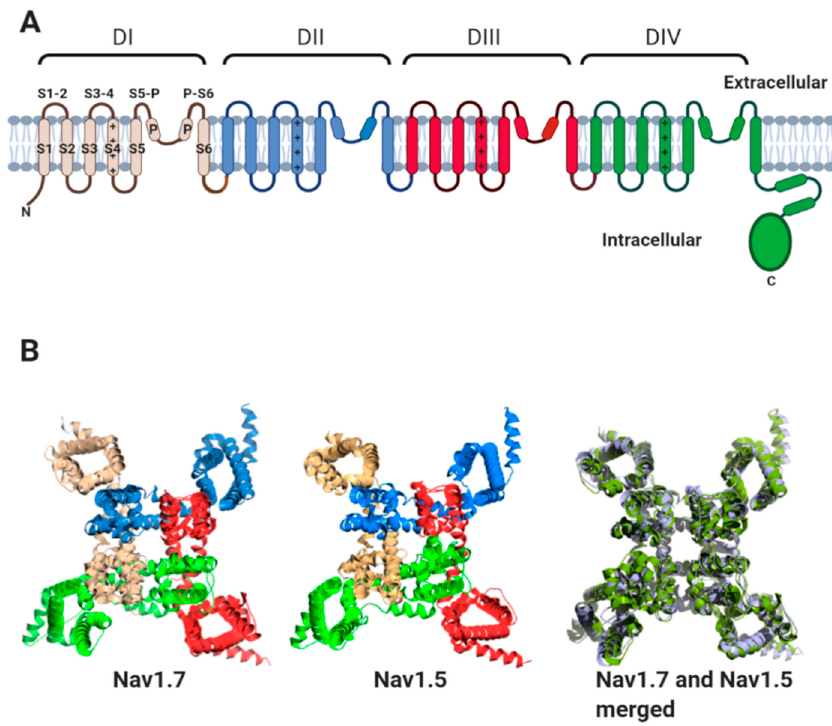
Figure 2. The Nav channel α -subunit. ( A ) Cartoon representation showing internally homologous domains DI-DIV. In DI, the location of transmembrane alpha-helices, S1–S6, the extracellular loops (S1-2; S3-4; S5-P and P-S6) and the re-entrant P helices are indicated. The positive charges on the S4 helices of each domain are indicated. ( B ) Three-dimensional structures of human Nav1.7 (PDB: 6JH8I), rat Nav1.5 (PDB: 6UZ3), and their aligned structures. The channels are viewed from above the plane of the plasma membrane. For Nav1.5 and Nav1.7, the domains DI-DIV are coloured as in ( A ). For aligned structures, Nav1.7 is coloured blue–white and Nav1.5 is coloured pale green.